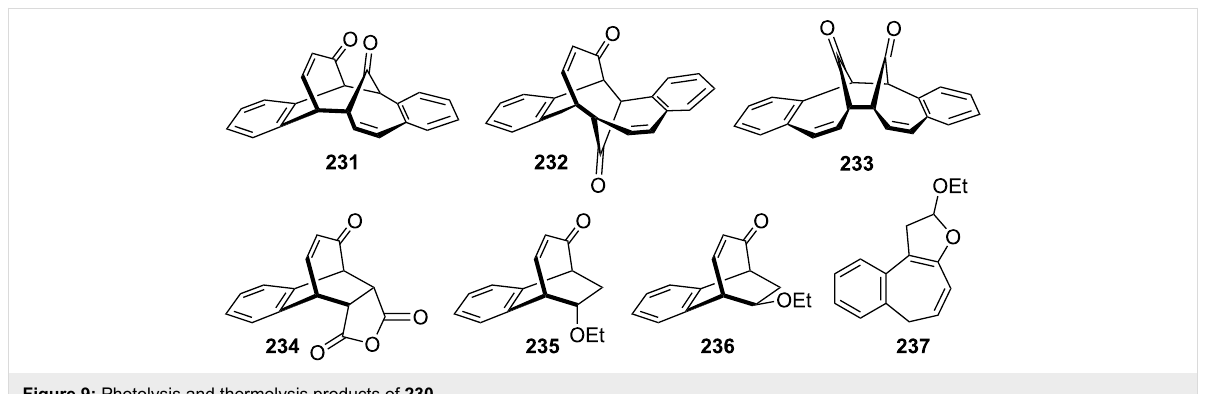
Figure 9: Photolysis and thermolysis products of 230 .